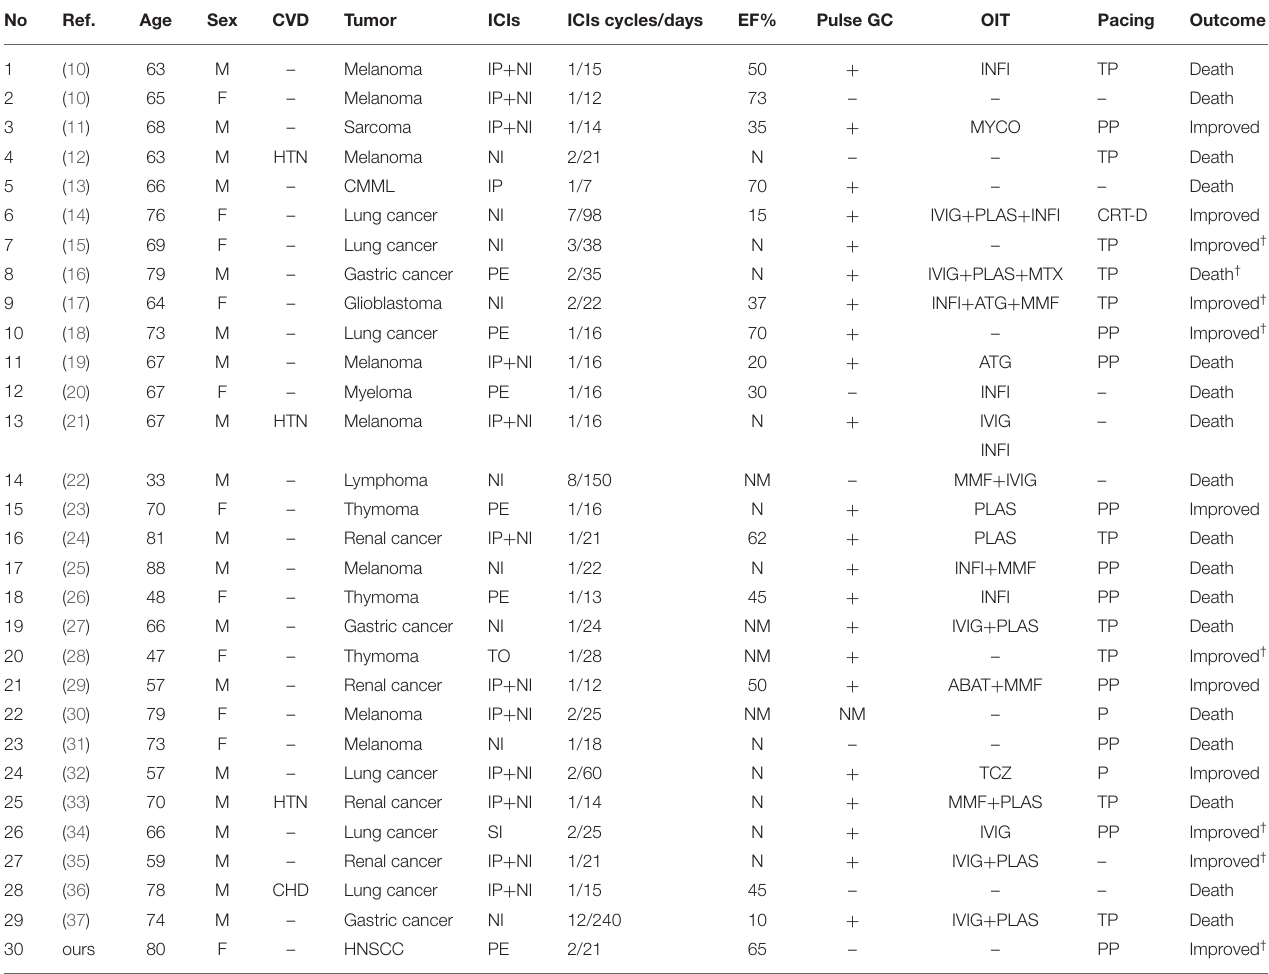
CVD,cardiovasculardisease;ICIs,immunecheckpointinhibitors;EF,ejectionfraction;OIT,otherimmunosuppressivetherapy;GC,glucocorticoids;M,male;F,female;HTN,hypertension; CMML,chronicmyelomonocyticleukemia;HNSCC,headandnecksquamouscellcancer;CHD,coronaryheartdisease;IP,ipilimumab;NI,nivolumab;PE,pembrolizumab;SI,sintilimab; TO, toripalimab; INFI, infliximab; MMF, mycophenolate mofetil; PLAS, plasmapheresis; IVIG, intravenous immunoglobulins; MTX, methotrexate; ATG, anti-thymocyte globulin; ABAT, abatacept; TP, temporary pacemaker; PP, permanent pacemaker; P, pacemaker; CRT-D, cardiac resynchronization therapy defibrillator; TCZ, tocilizumab; N, normal; NM, not mention. † Recovery to sinus rhythm from complete heart